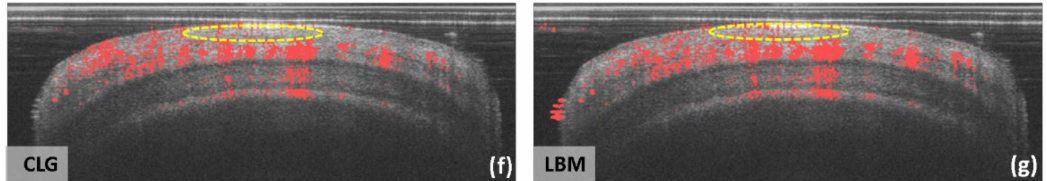
Figure 4. IDa-OCTA imaging of the little finger nailfold of a healthy volunteer with the endoscopic clinical proximal-end scanning catheter and the conventional galvanometric scanner. ( a ) Endoscopic cross-sectional structure of the nailfold. ( b ) Endoscopic cross-sectional IDa-OCTA angiogram before correction. ( c ) Conventional cross-sectional IDa-OCTA angiogram obtained by imaging a similar nailfold position with a galvanometric scanner. Endoscopic cross-sectional IDa-OCTA angiogram after using CLG correction ( d ) and after using LBM correction ( e ). Left insets are enlarged views of the enclosed areas. Corresponding vessels are labeled by the yellow arrows. Overlay of the CLG- corrected endoscopic IDa-OCTA angiogram (red, ( f )) and the LBM-corrected endoscopic IDa-OCTA angiogram (red, ( g )) on the cross-sectional structure (gray). Corresponding residual noise is circled by yellow ellipses. EP: epidermis, DE: dermis, NM: nail matrix, NR: nail root, NB: nail bed. A kernel of 5 × 3 × 5 (z × x × t) was adopted in IDa-OCTA calculation. Scale bar = 0.5